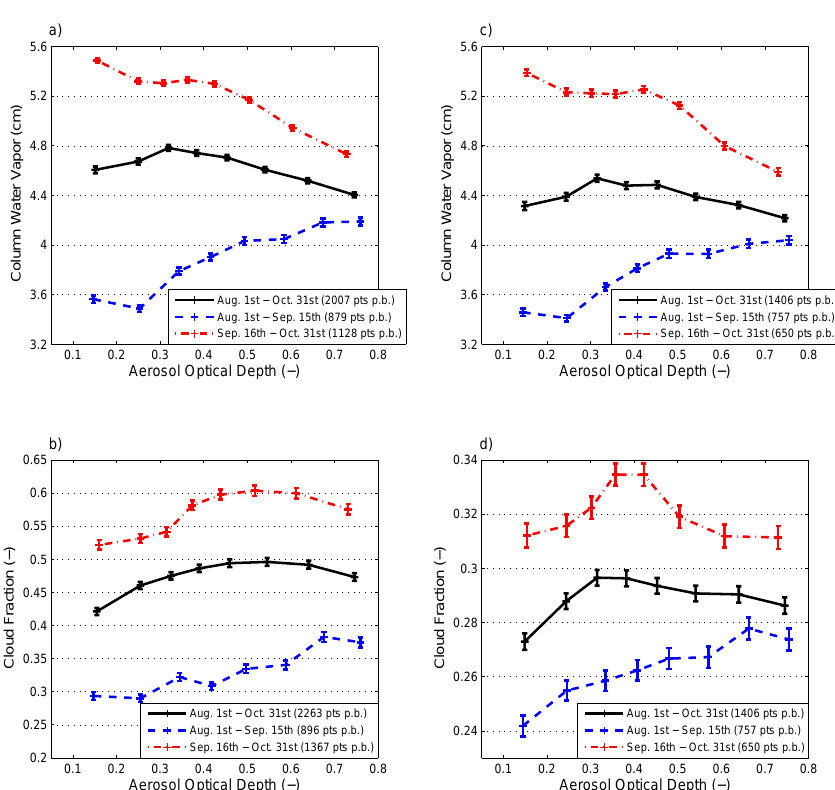
Fig. 4. (a) Column water vapor binned by aerosol optical depth for all co-located warm cloud retrievals for the months of August through October, for the years 2004 through 2007. Error bars denote the standard error in each bin. (b) Cloud fraction binned by aerosol optical depth for all warm cloud retrievals for the same time period as in (a) . (c) Column water vapor binned by aerosol optical depth for all co-located warm cloud retrievals with cloud fractions less than 0.5. (d) Cloud fraction binned by aerosol optical depth for all warm cloud retrievals with cloud fractions less than 0.5. The number of retrievals included each bin is noted in the